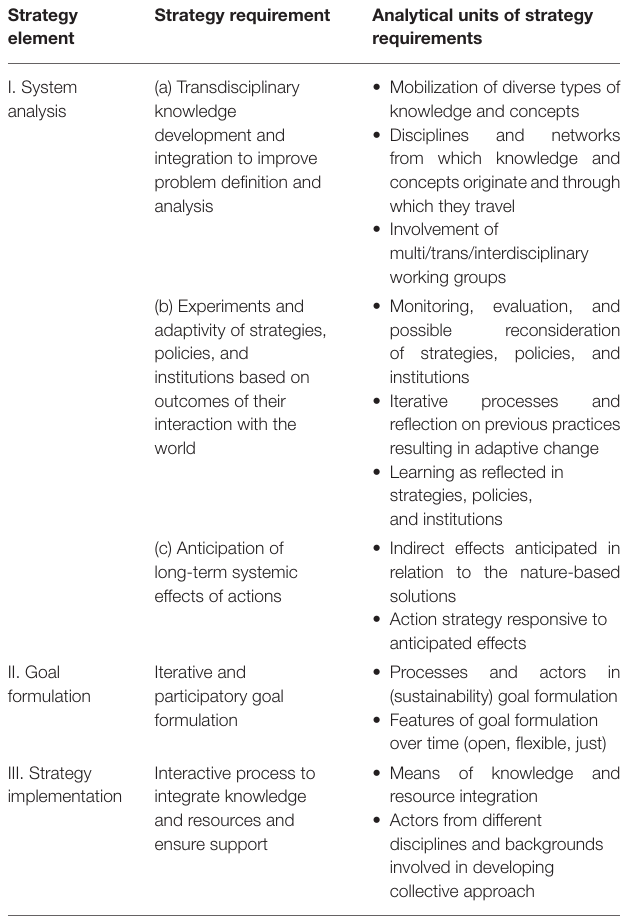
TABLE 1 | Analytical framework to study reflexive